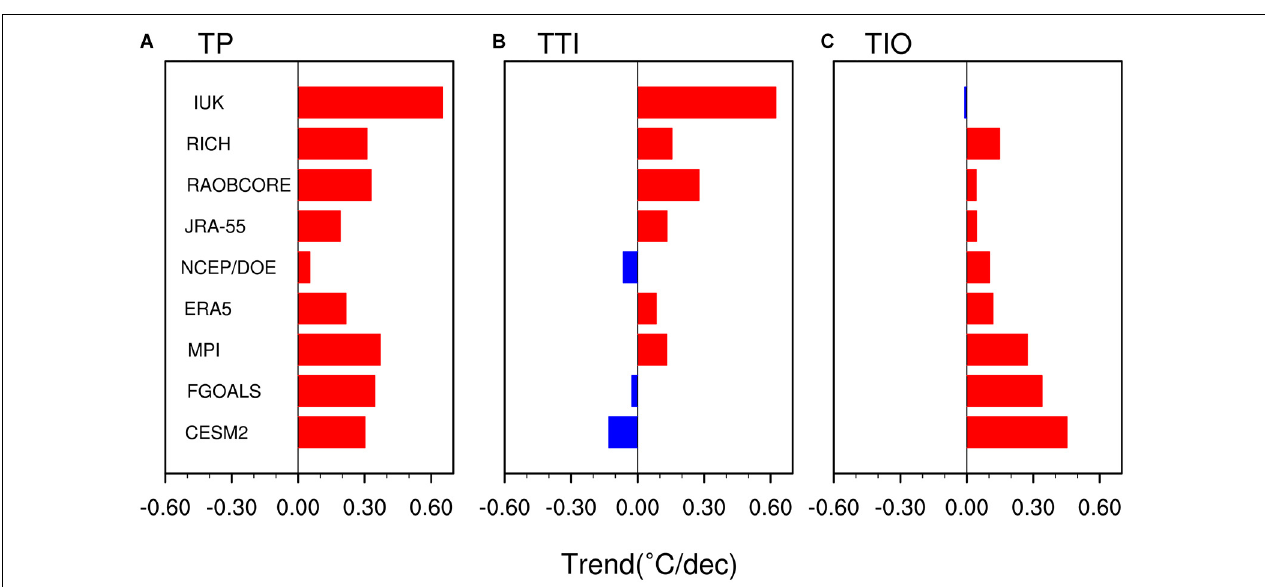
FIGURE 3 | The interannual variations of the thermal contrasts TTI in Radiosondes (A) and Reanalyses (B) (solid lines represent 10-year running averaged of three datasets in each panel, and the shading represents the ensemble of the three datasets).